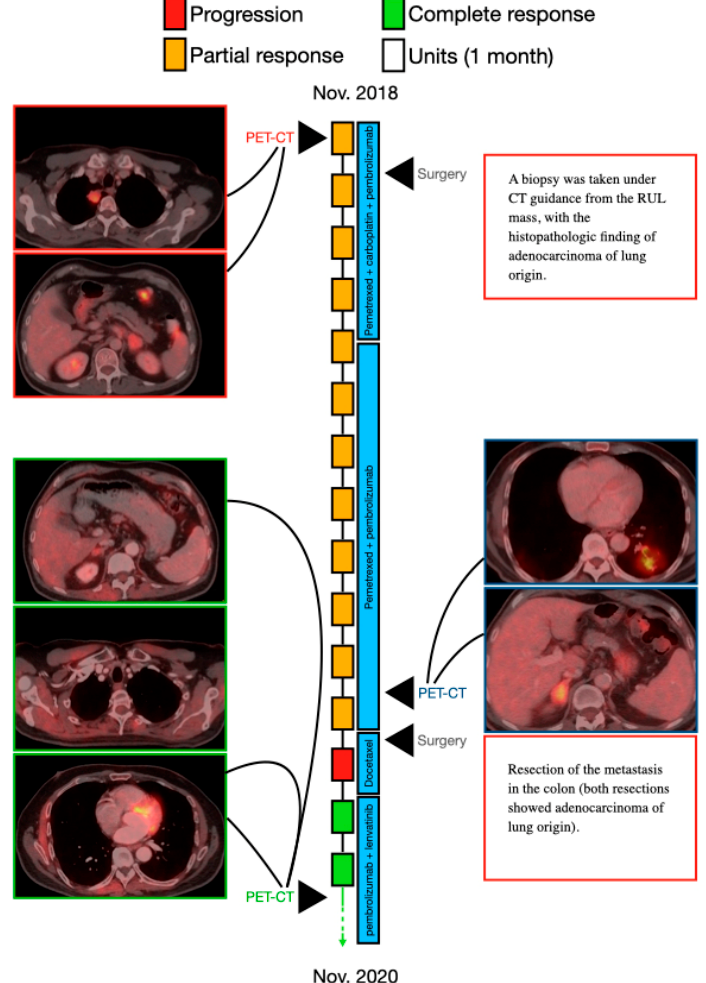
Figure 1. A schematic illustration of patient 1 (cid:48) s timeline, between November 2018 (diagnosis of the disease) and November 2020, including the course of treatment and radiological follow-up. Each rectangle represents 1 month, and the response to treatment during each month is color-coded in green, red, or yellow, as described in the upper legend. Treatment administered at each timepoint is indicated by the blue rectangles. Radiological findings and additional landmarks are presented at relevant points throughout the